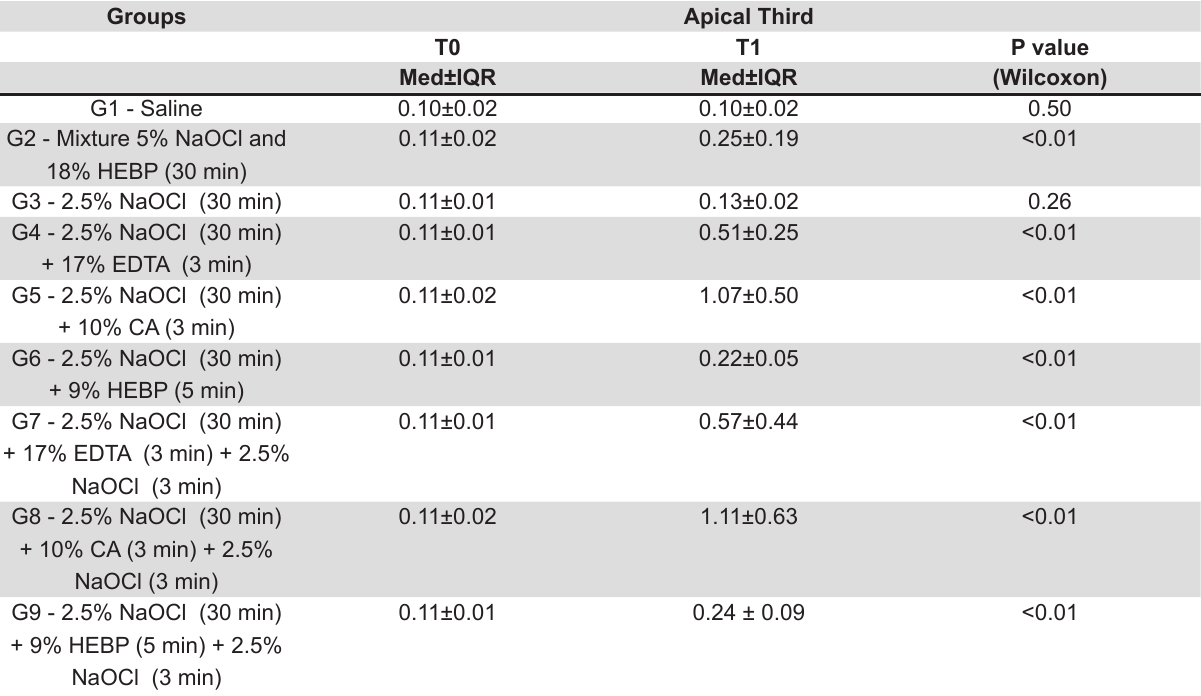
Table 3- Median (Med) and interquartile range (IQR) and P values (Wilcoxon test) for roughness analysis in the apical third before (T0) and after (T1) the application of the irrigation